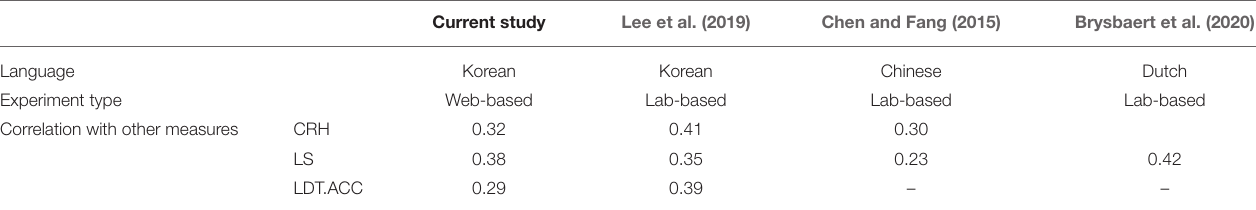
TABLE 2 | Summary table of correlations between author recognition tests and other measures in recent